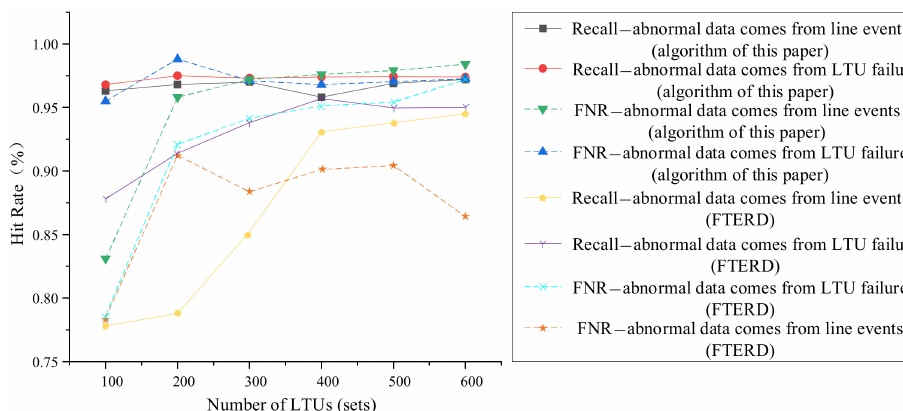
Figure 10. Spatial correlation index curve of abnormal data from LTU failures ( a ) and abnormal data from line events ( b ).